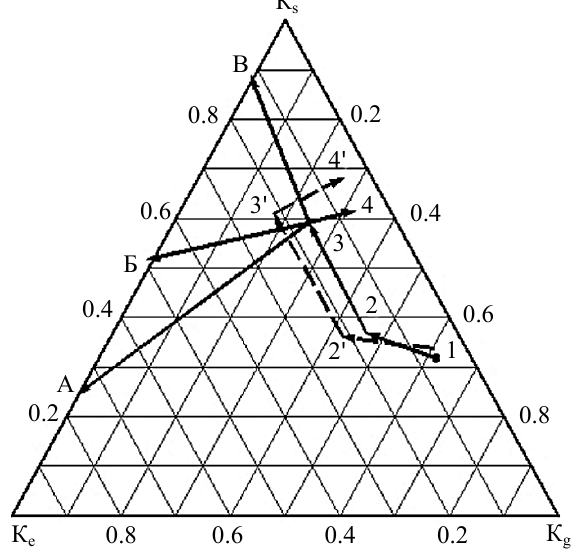
Fig. 7. Phase diagrams of the trajectory of